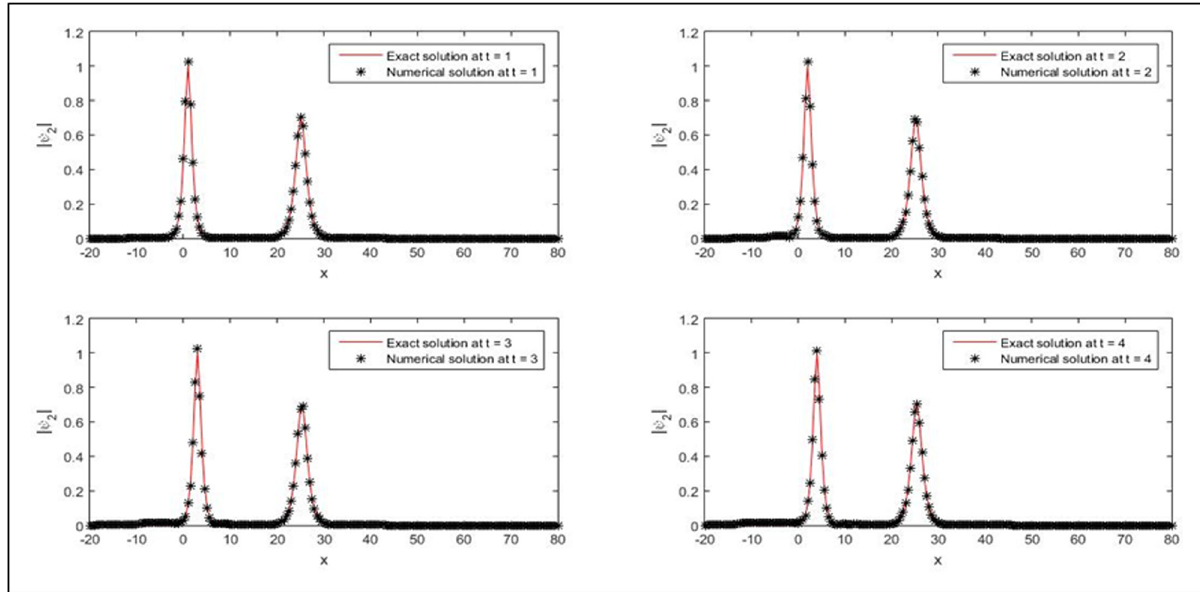
Figure 4: Numerical and exact values of second - wave amplitudes respectively for = N 201 ,